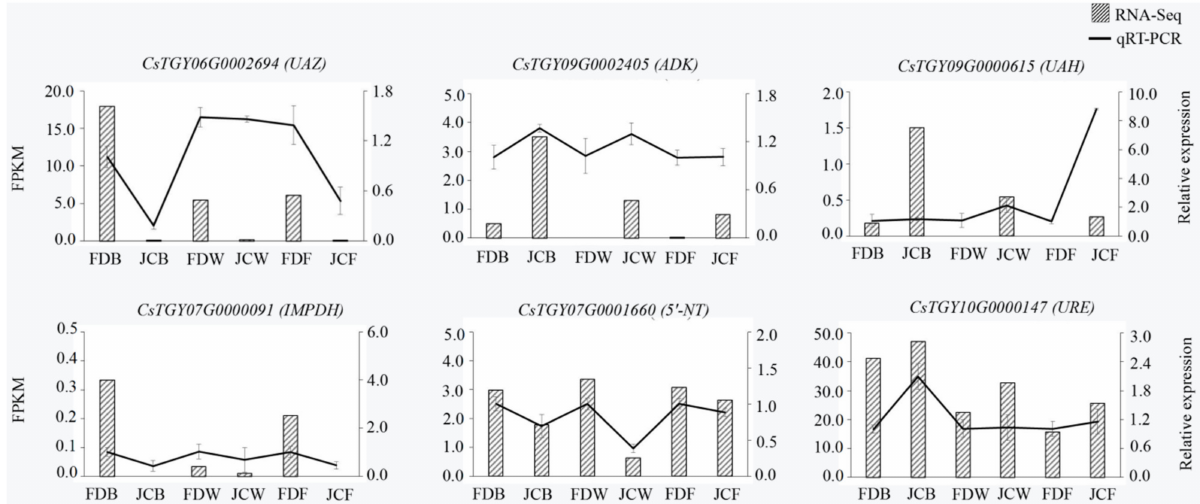
Figure 10. Validation of transcriptome sequencing data by